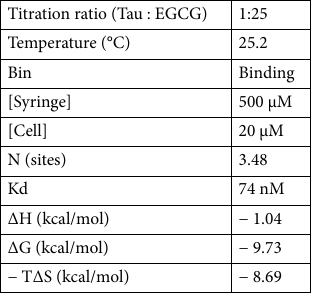
Table 1. Parameters and calculated values for Tau-EGCG binding